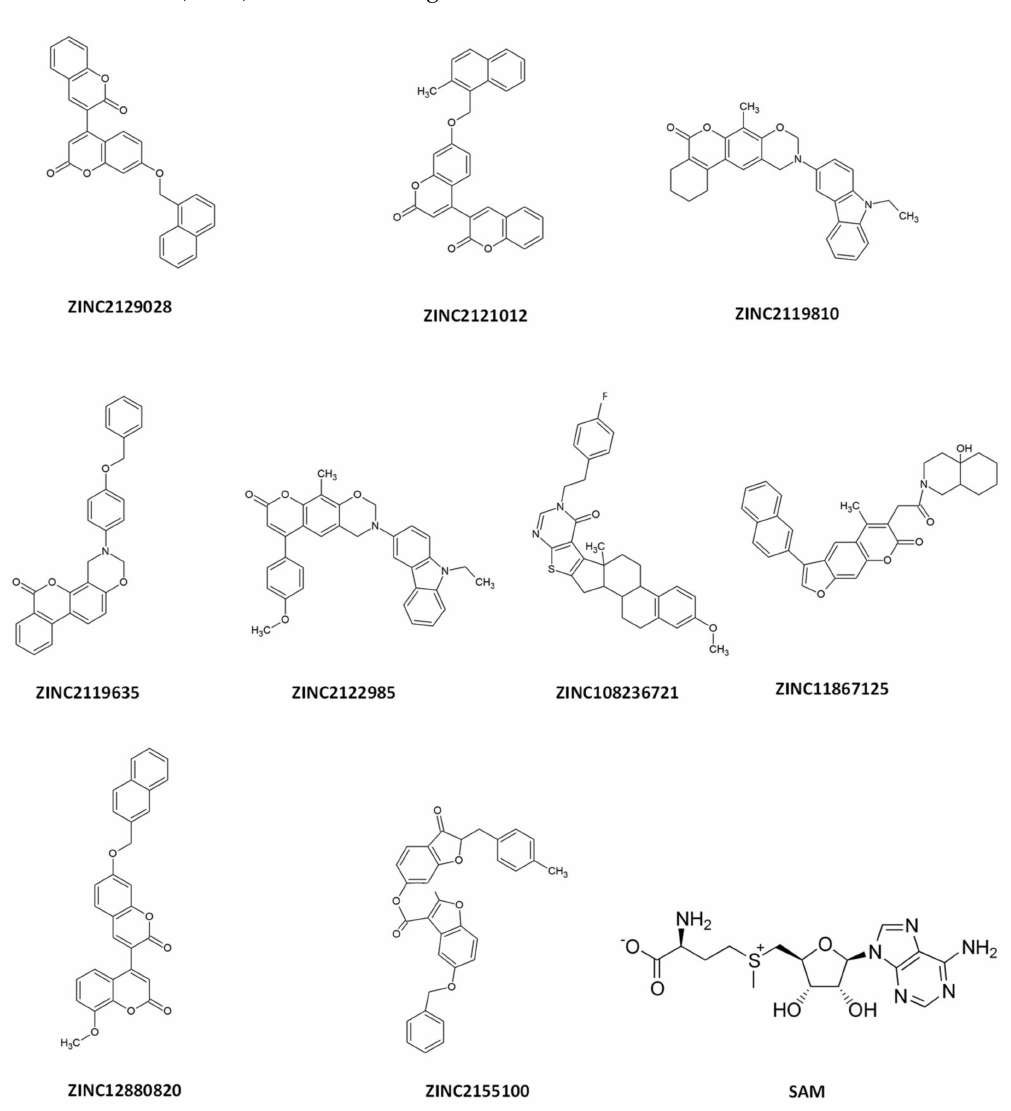
Figure 3. Chemical structures of the selected ligands and